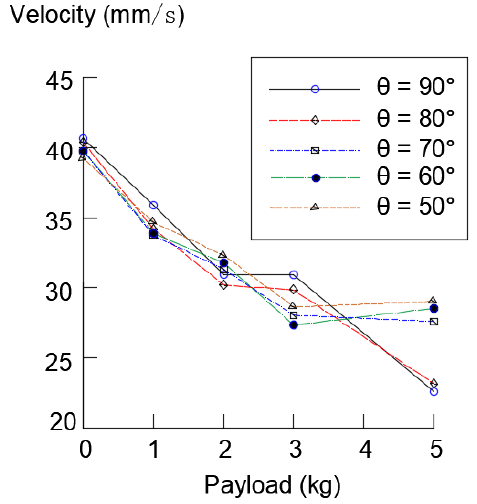
Figure 15. Depiction of the results of the climbing speed.